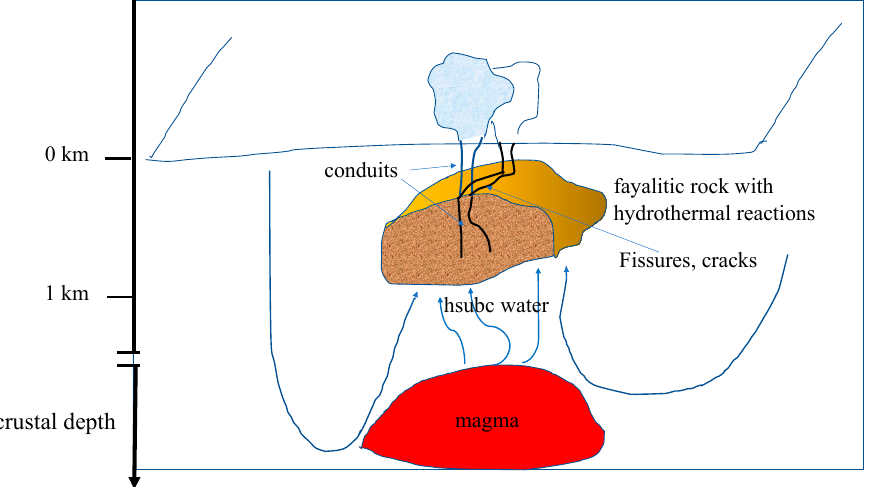
Figure 6. A schematic illustration of a kind of magmatic hydrothermal reaction chamber located within a depth of 1 km of the upper crust, on Earth, and containing fayalite and/or ferrosilite in interaction with high subcritical water that has been heated near magma. The hsubc water is anoxic. Quartz and amorphous silica, the ferric oxides goethite and hematite, amorphous ferric silicates, and the crystalline ferric silicates greenalite and minnesotaite form, possibly with the dehydration products riebeckite and stilpnomelane. When the water is carbonated, siderite forms and produces magnetite after hydrolysis in hsubc water. The released H 2 can be captured inside inclusions, together with CO 2 and N 2 , to form components of life [7] and the fifth process described in the Section 3.1.